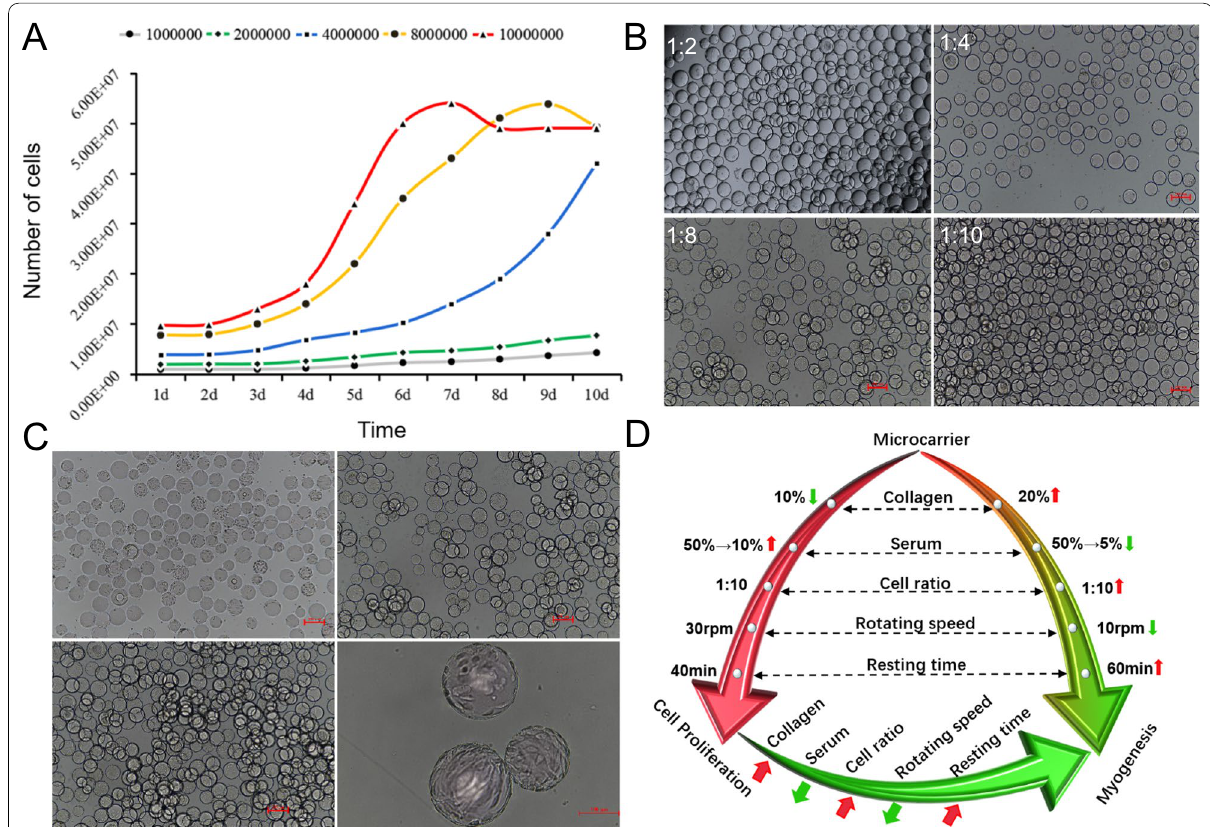
Fig. 5 Number of inoculated cells and evaluation results of comprehensive optimization conditions. A Cell proliferation curve in spinner flask and microcarrier culture with different numbers of inoculated cells. B Morphology of inoculated cells attached to the microcarriers. C Comprehensive evaluation of the optimized conditions for the promotion of cell proliferation culture system. D Schematic of the adjustment of key parameters in different optimization schemes (large-scale cell proliferation system and myogenic